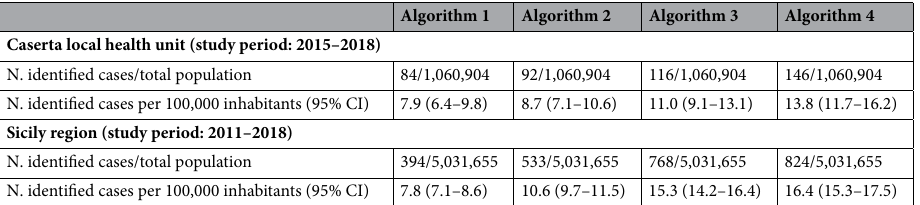
Table 2. Number of subjects identified by each proposed algorithm as having acromegaly (cases) in Caserta Local Health Unit (period January 2015–December 2018) and in Sicily Region (period January 2011– December 2018). CI = confidence interval calculated using the exact Clopper–Pearson method for a binomial proportion.